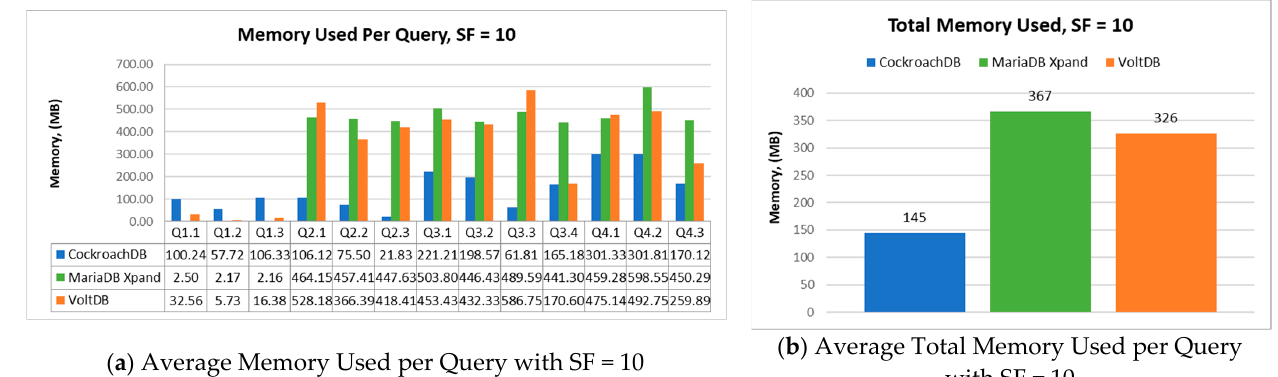
Figure 12. Results of memory usage with SF = 10.